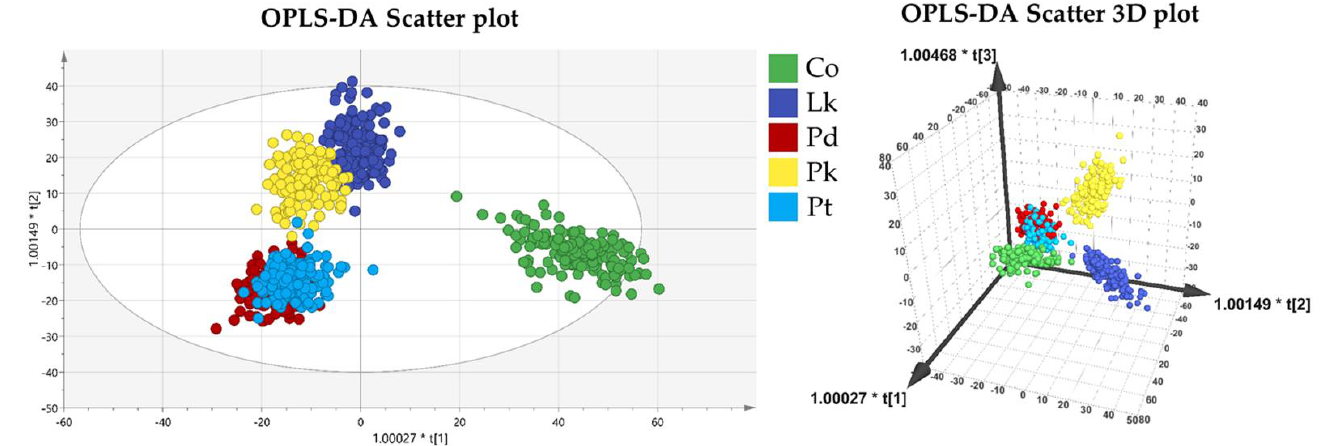
Figure 4. OPLS-DA scatter plot and 3D plot for Chamaecyparis obtusa (Co), Larix kaempferi (Lk) (Lamb.) Carr., Pinus densiflora (Pd), Pinus koraiensis (Pk), and Pinus thunbergii (Pt). Statistical parameters of the model: number of samples, 750; R 2 X, 0.797; R 2 Y, 0.841; Q 2 , 0.813.